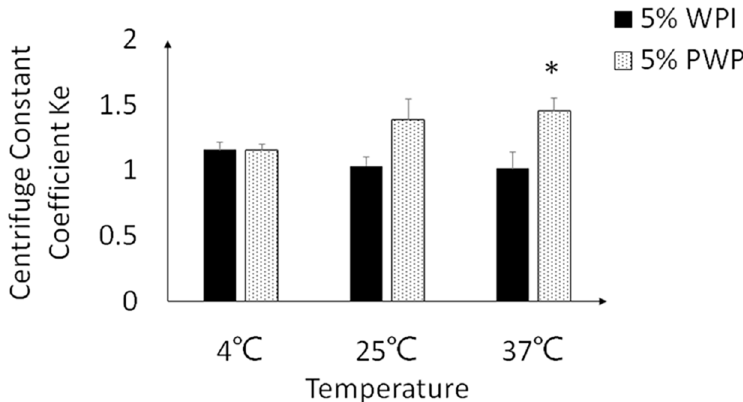
Fig 1. The centrifuge constant coefficient Ke values of the dispersions with WPI or PWP at different temperatures. The centrifuge constant coefficient Ke values of the dispersions with WPI or PWP were tested at temperatures of 4˚C, 25˚C and 37˚C. (cid:3) means significant different between WPI and PWP based nano-emulsions at p < 0.05. Value = mean ± SEM, n = 3.